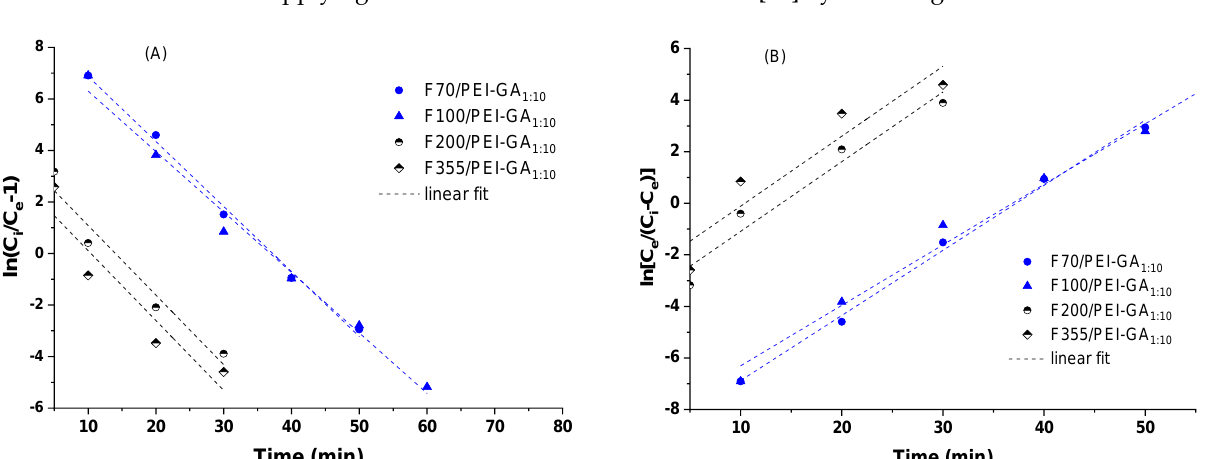
Figure 8. Linear plots of Thomas ( A ) and Yoon–Nelson ( B ) models for sand composites with different core sizes and the same cross-linking degree (x = 0.1).